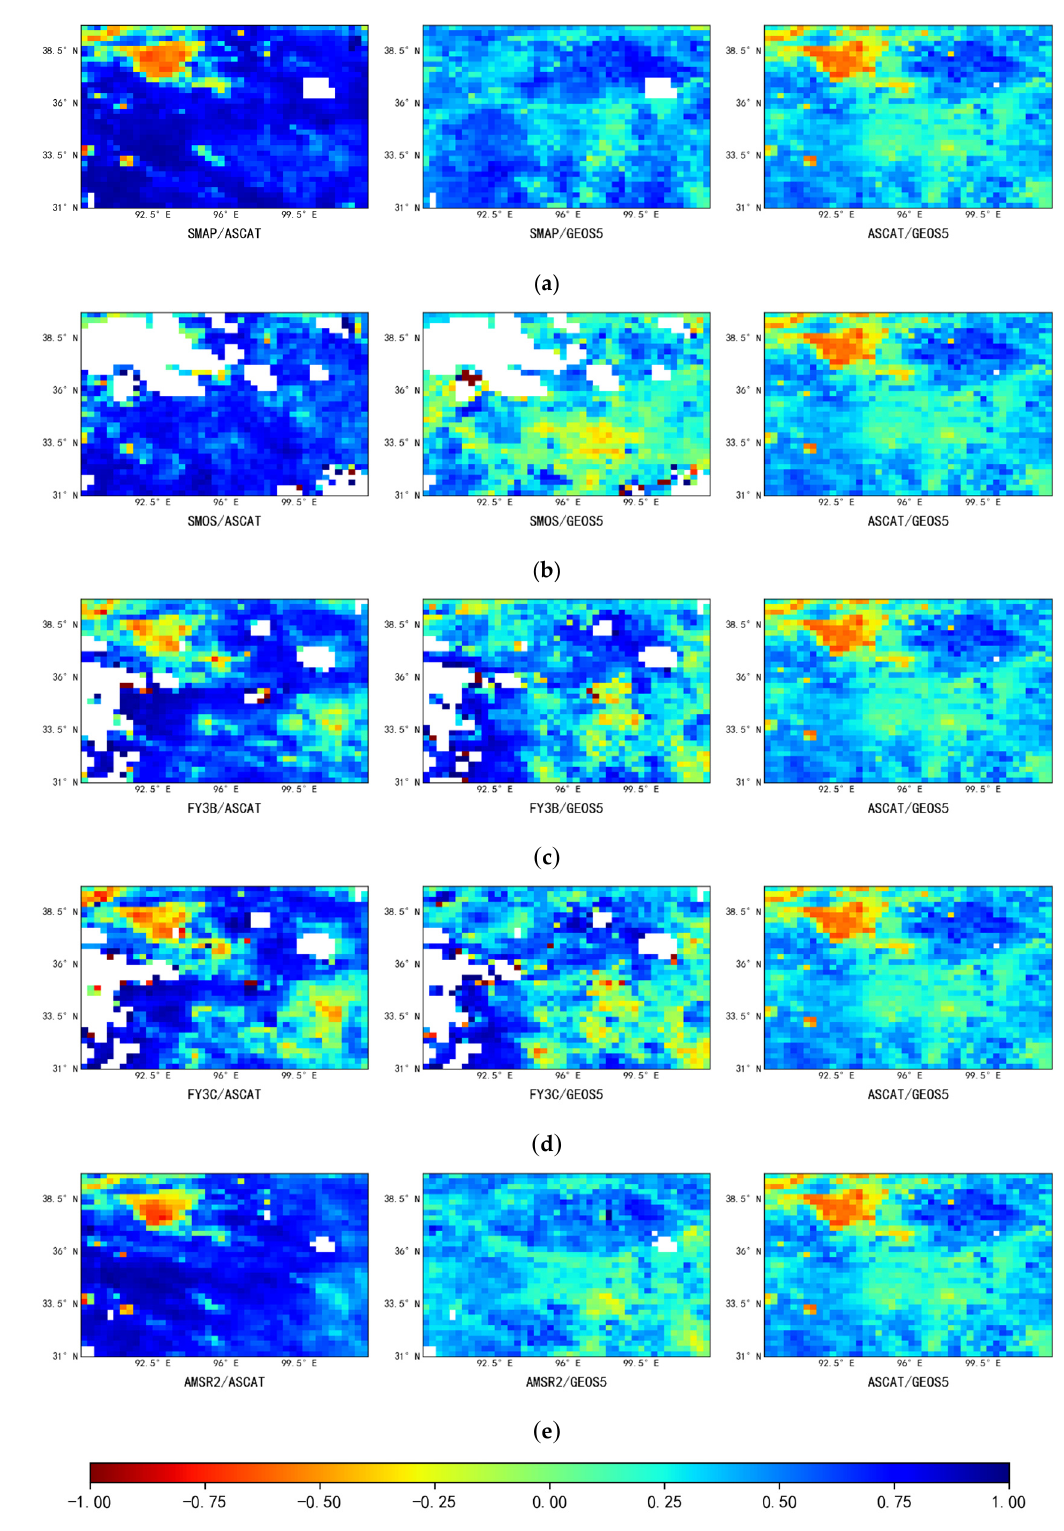
Figure 3. Correlation coe ffi cients between soil moisture data. The five columns of sub-figures show, from top to bottom: ( a ) [SMAP, ASCAT, GEOS5]; ( b ) [SMOS, ASCAT, GEOS5]; ( c ) [FY3B, ASCAT, GEOS5]; ( d ) [FY3C, ASCAT, GEOS5]; ( e ) [AMSR2, ASCAT, GEOS5]. The three rows of sub-figures show, from left to right, the correlation coe ffi cients between passive and active, passive and reanalysis, and active and reanalysis